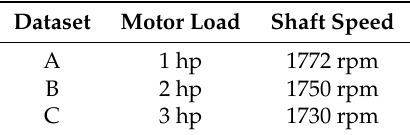
Figure 6. Sliding window data augmentation. Table 3. Operating conditions considered in these experiments.